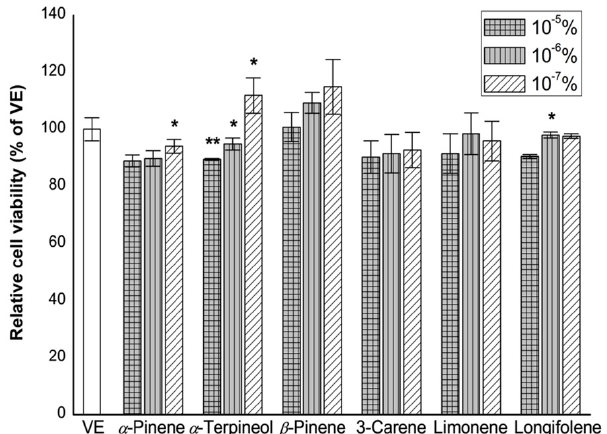
Figure 5. Effect of single compounds on the RBL-2H3 cell viability. RBL-2H3 cells were seeded in 96-well plate and treated with a series of concentration of the six single compounds (10 − 5 , 10 − 6 , and 10 − 7 %) for 24 h. Cell viability was assessed by cell counting kit-8 assay. VE: vehicle, DMSO. The results are presented as mean ± standard deviation. * p < 0.05 and ** p < 0.01 compared with VE.